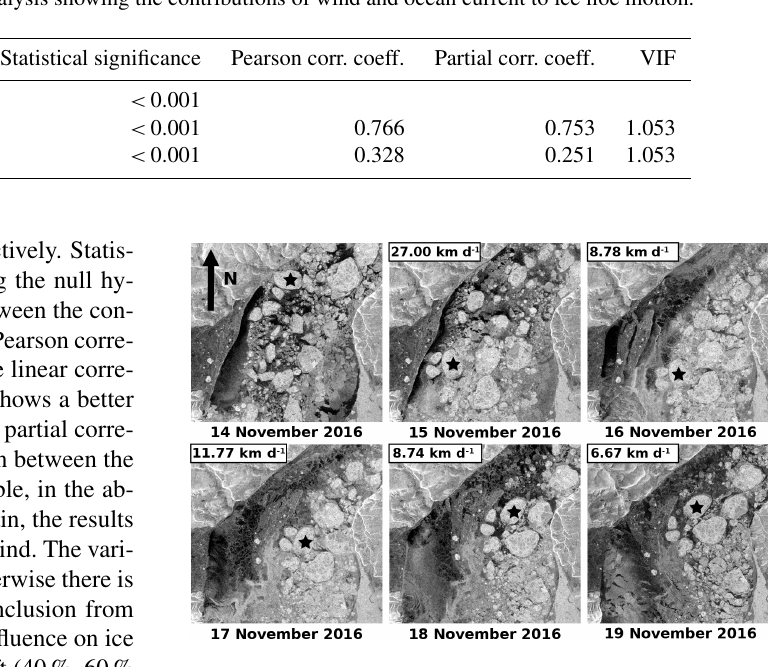
Figure 11. A sequence of daily Sentinel-1 images showing the path of a number of ice floes. The floe marked by the asterisk (floe no. 29) is the subject of the comments in the text. Dates of the images are shown, as well as the speed of the marked